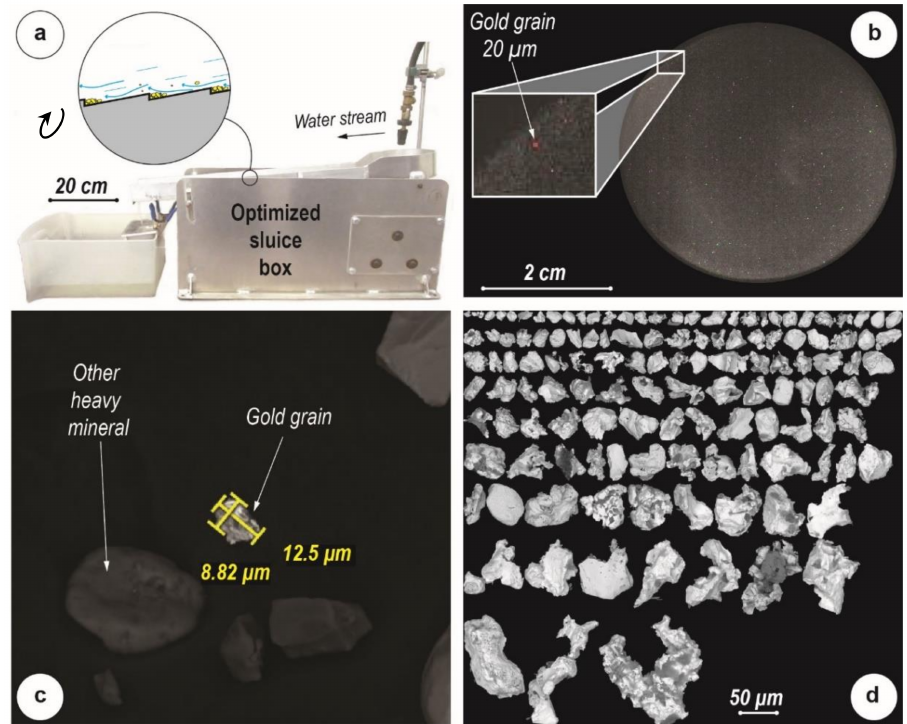
Figure 3. Key features of the improved method. ( a ) The fluidized bed used to concentrate the grains (the cartoon illustrates the behavior of gold grains in the lamellar hydraulic flow and elliptical motion of the bed). ( b ) Example of a custom-made holder dusted with the material that was − 50 µ m (bright spots are the heaviest minerals). ( c ) Example of a high-magnification back-scattered electron image of a gold grain (among other heavy minerals) used for size measurement. ( d ) Example of an automated back-scattered electron image mosaic of gold grains recovered from a single till sample. Gold grains as small as 2 µ m in equivalent diameter can be